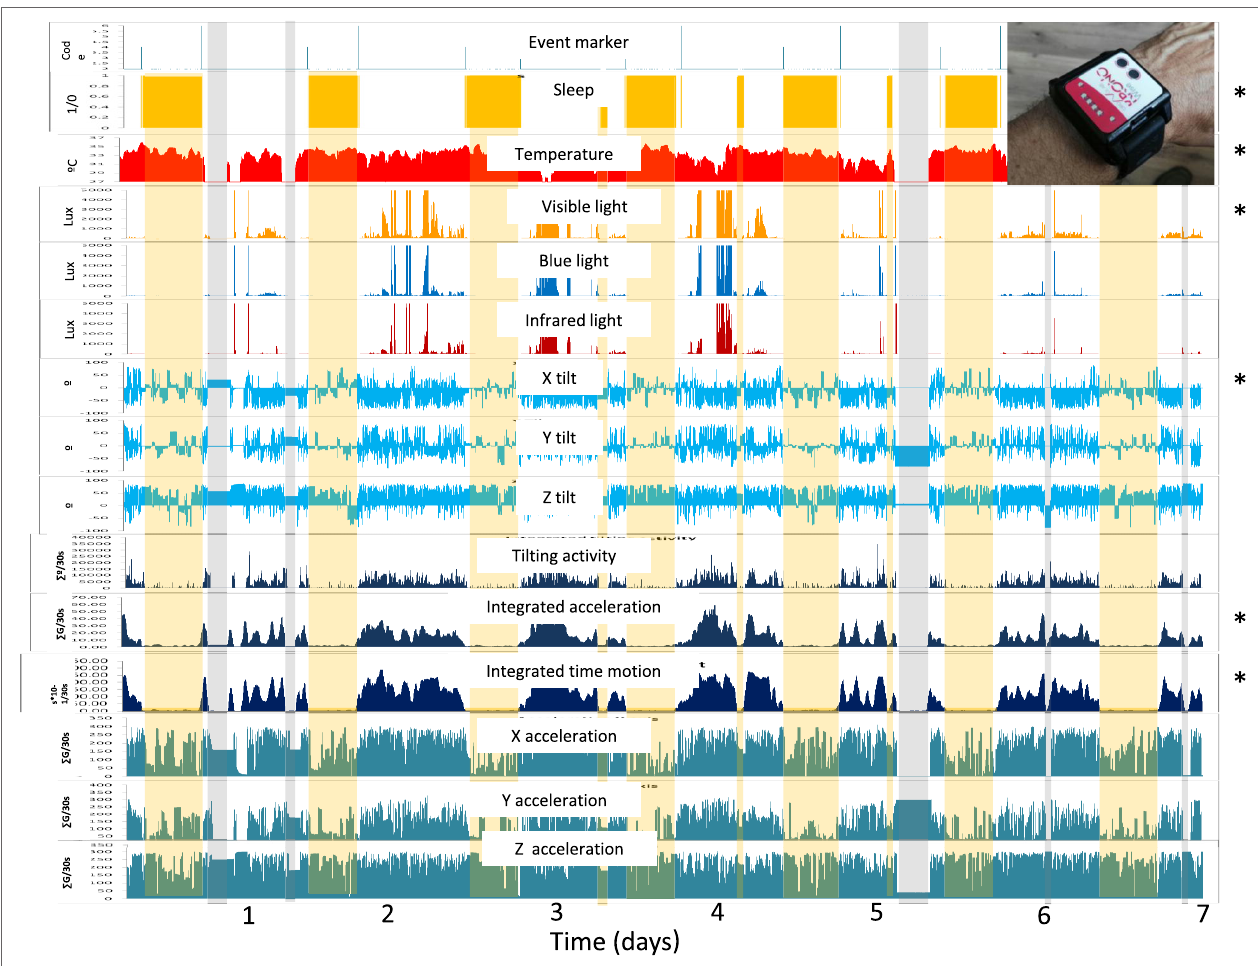
FigUre 1 | Overview of the fifteen variables recorded during a full week by the ACM device on the wrist of a Parkinson’s disease patient, as processed by Kronoware 10.0 software (Kronohealth SL). From top to bottom: events; sleep (orange bars); skin temperature (red) in °C; visible, blue, and infrared light (orange, blue and red) in luxes; three axis tilt (blue) °/epoch; integrated tilting changes, acceleration and time in movement (dark blue); and partial acceleration of each axis (green). Gray bars indicate “time off” from wearing the device while the yellow bar represents the inferred sleep periods. Asterisks indicate variables selected for the circadian and sleep characterization of Parkinson’s disease